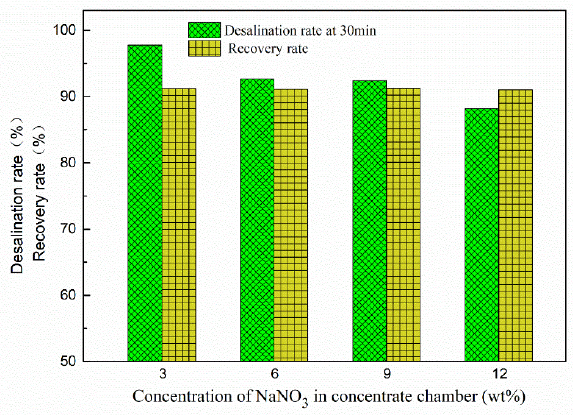
Figure 9. Energy consumption and current e ffi ciency for di ff erent electrolyte salt concentrations. Figure 10 indicates the energy consumption and current e ffi ciency for di ff erent electrolyte